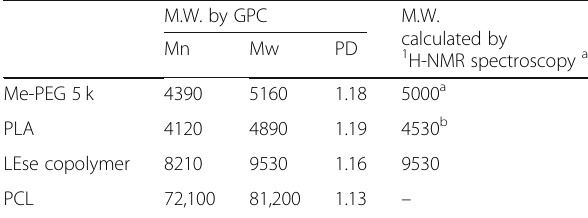
Table 1 Characterization of